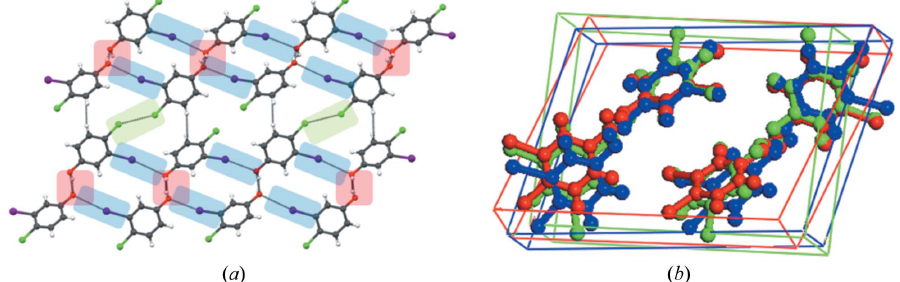
Figure 4 4-Chloro-3-iodophenol ( 4 ): ( a ) Packing diagram with O—H (cid:2)(cid:2)(cid:2) O hydrogen bonds (red), type II I (cid:2)(cid:2)(cid:2) O (blue) and type I Cl (cid:2)(cid:2)(cid:2) Cl (light green) interactions. ( b ) Structural overlap between ( 3 ) (red), ( 4 ) (blue) and ( 5 ) (green).